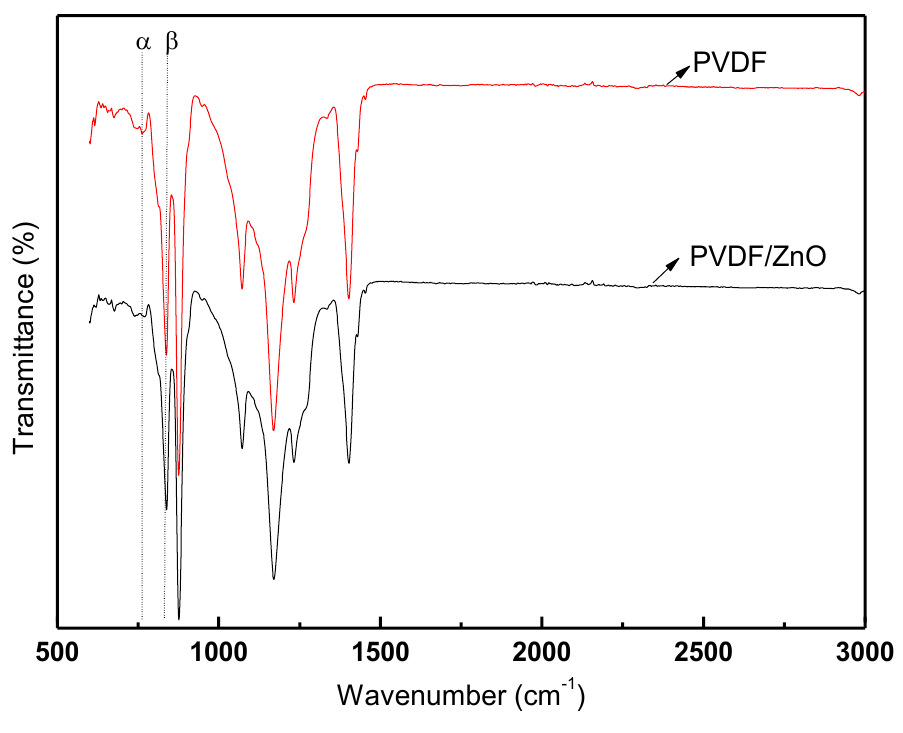
Figure 6. FTIR spectra of PVDF and PVDF/ZnO. With the loading of a small amount of the nanofillers, no appreciable changes in the structural and bonding environment of PVDF are seen. All composite membranes’ FTIR spectra contain the typical absorption bands that characterize the structural properties of PVDF. The distinctive absorption bands of the nonpolar α are seen at 763 cm − 1 , 795 cm − 1 , 855 cm − 1 , and 976 cm − 1 in the FT-IR spectra for the pure PVDF film, while the bands of the polar β -phase are shown at 840 cm − 1 , 1276 cm − 1 , and 1431 cm − 1 , according to related reports in the literature [51–54]. By comparing the absorption peaks of the β and α phases at the wavelengths 840 cm − 1 and 763 cm − 1 , respectively, it is possible to estimate the proportion of the beta crystalline phase in each sample. Using the Lambert-Beer law, the electroactive β -crystal content (F( β )) of the samples are evaluated [55]. A β × 100% F ( β ) = (cid:16) K (cid:17) β A α + A β K α Here, A α and A β is the absorbance of α and β phases at 763 cm − 1 and 840 cm − 1 , respectively. K α and K β stand for the absorption coefficients, with respective values of 6.1 × 10 4 and 7.7 × 10 4 cm 2 mol − 1 . Figure 7 shows a bar chart representation of the evaluated F( β ). It is found that the F( β ) of PVDF nanofibers can be enhanced by adding ZnO nanoparticles. In addition, the PVDF/ZnO (SN-8) nanocomposite film exhibits a higher F( β ) value (85%) than the only PVDF film (63%). The surface of nanoparticles with a negative charge density and the CH 2 groups of the PVDF chains with a positive charge density effectively interact to cause the nucleation of the β -phase crystallite in nanoparticles doped PVDF composite